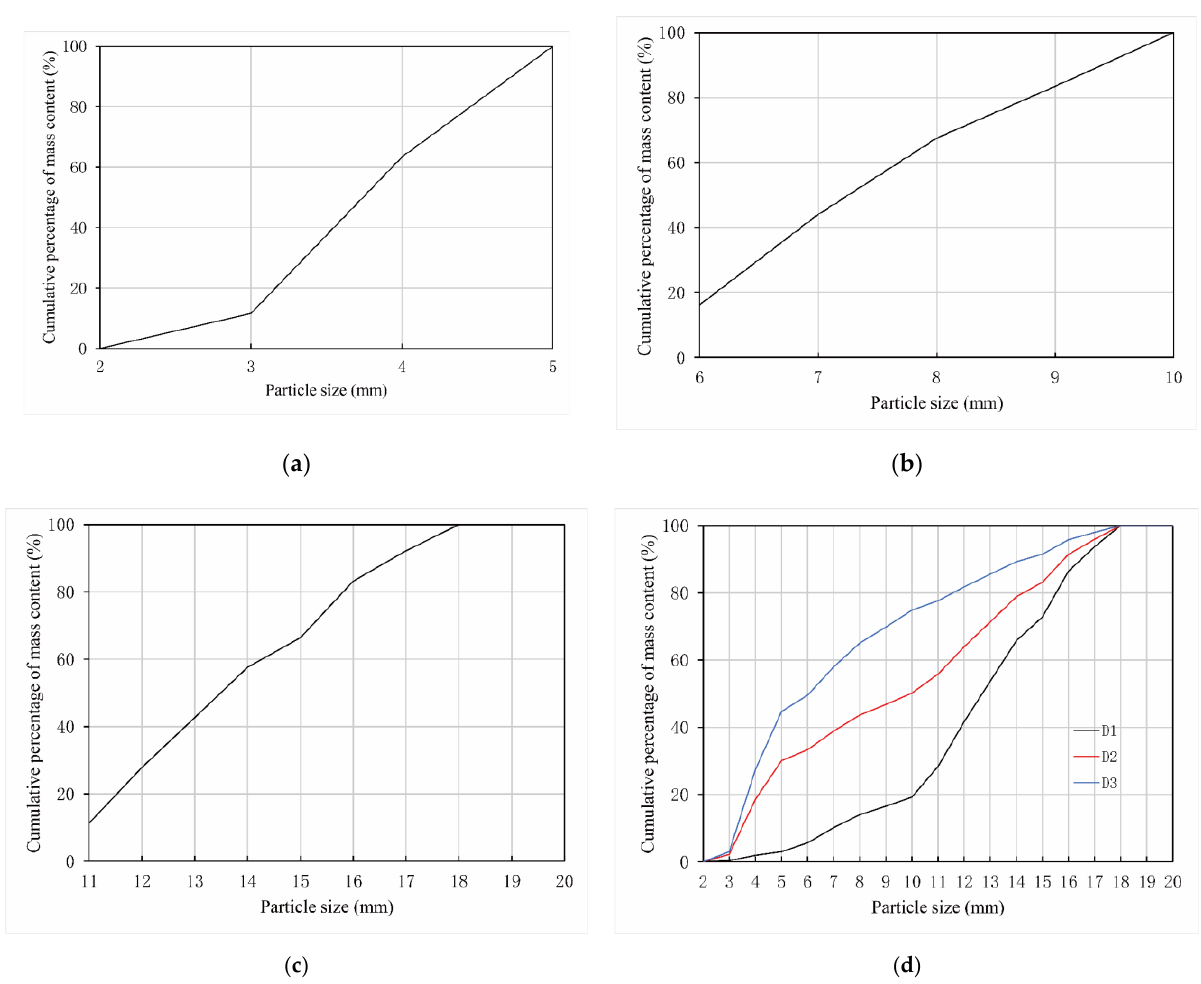
Figure 7. Particle size distributions of the gravel. ( a ) D Ⅰ , size range was 2 – 5 mm. ( b ) D Ⅱ , size range was 5 – 10 mm. ( c ) D Ⅲ , size range was 10 – 20 mm. ( d ) D1, D2, and D3 particle size distributions in the laboratory test.